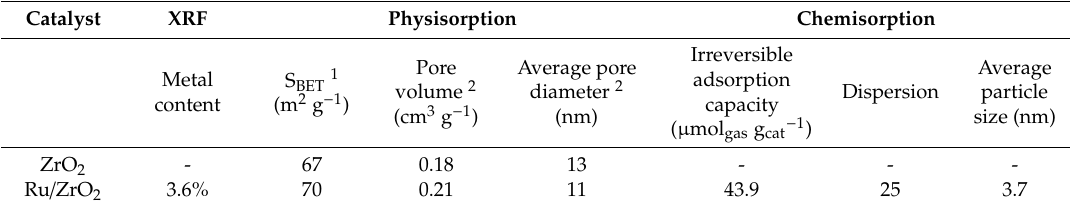
Table 1. Summary of the characterization results from X-ray fluorescence (XRF), physisorption, and